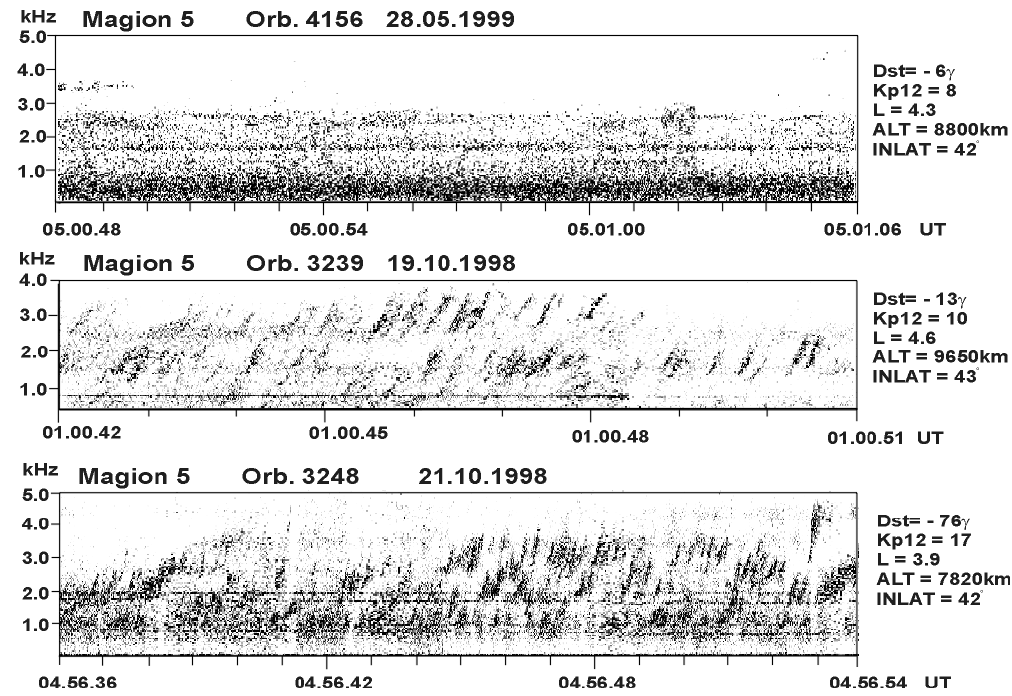
Fig. 2. Typical dynamic spectra of VLF chorus emissions on board of Magion 5 satellite for different magnetic disturbances. K p 12 is the total value of K p index for the preceding